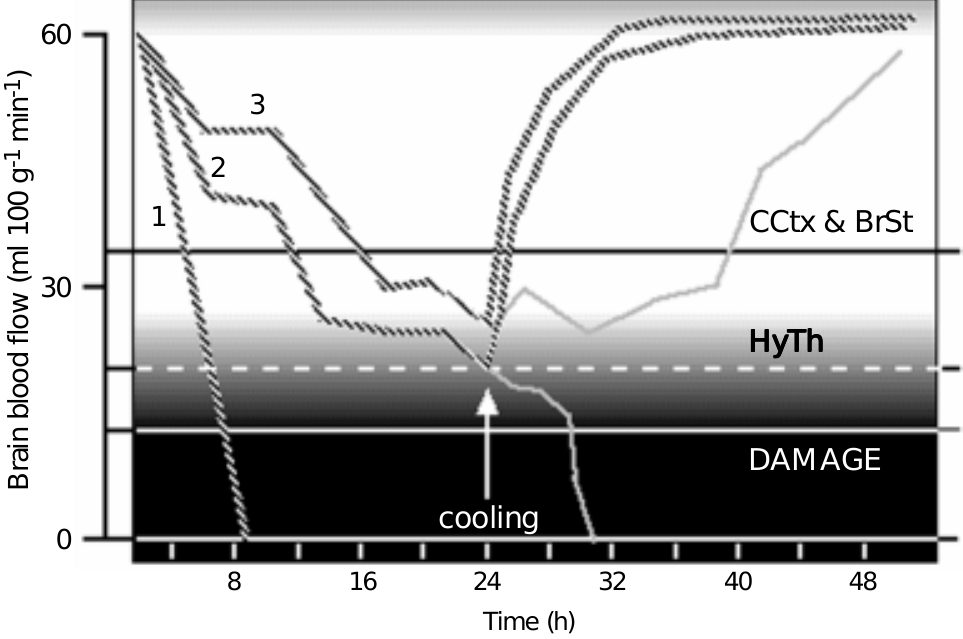
Figure 3 - Evolution of brain blood flow in three hypothetical cases of increased intracranial pressure (ICP): influence of mod- erate hypothermia (33 o C) in- duced at 24-h survival. Simulta- neous normalization of intracra- nial pressure observed during cooling to 33 o C (27) leads to re- circulation of cases 2 and 3 whilst case 1 is unaffected. Re- markable absorption of brain edema during the next few hours of hypothermic treatment should prevent recurrence of ICP (27). For abbreviations see leg- end to Figure